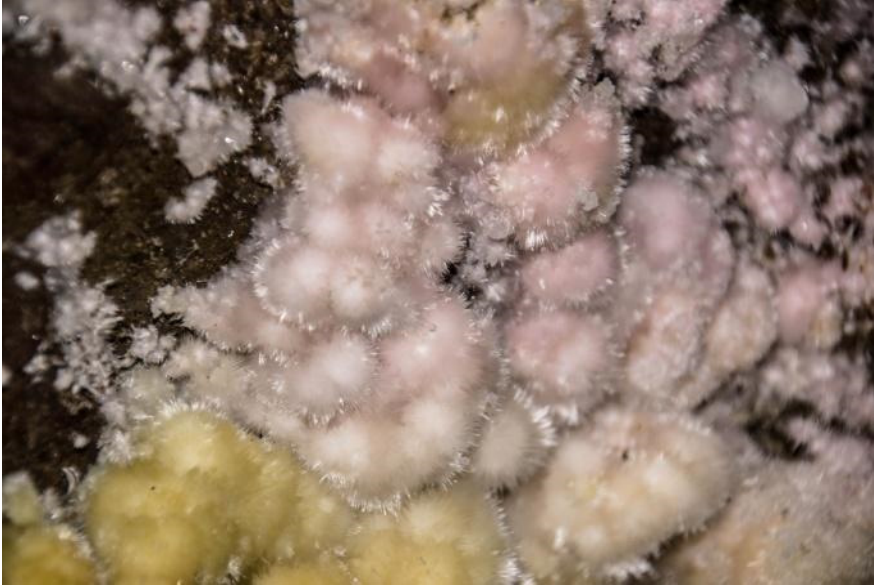
Figure 5. Gypsum from the Jozef adit (photo by Silvia Palgutová).